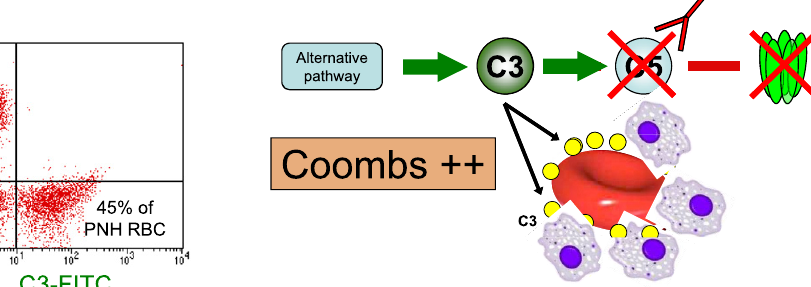
Figure 2. Mechanism of (iatrogenic) extravascular hemolysis in a paroxysmal nocturnal hemoglobinuria (PNH) patient on eculizumab. In untreated patients (upper cartoon), as soon as C3 (yellow circles) is bound to a GPI-negative red cell (lacking CD55), C5 will be activated, the membrane attack complex (MAC) will form, and the red cell (which also lacks CD59) will be lyzed: accordingly, no red cells with C3 bound are seen in the upper flow cytometry pattern on the left. In patients on eculizumab (lower cartoon), with C5 blocked, no MAC is formed and there is no lysis; in return, a much larger number of C3 molecules accumulate (see lower flow cytometry pattern on the left); thus, the red cell is opsonized and will be prey to macrophages. This is the likely mechanism of extravascular hemolysis in PNH patients on eculizumab (modified from